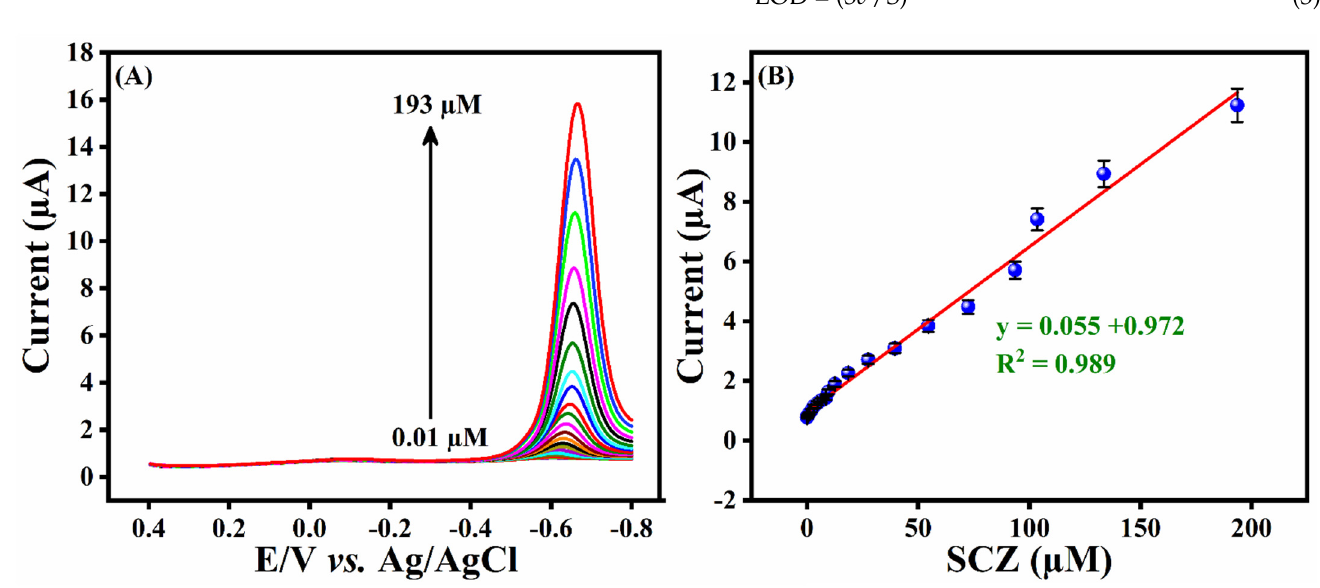
Figure 7. ( A ) DPVs of various concentrations of SCZ (0.01 to 193 μ M) at ZTO/TO MPs/GCE (electrolyte: 0.05 M PBS, pH 7.0), and ( B ) linear plot with peak current plotted as a function of the concentration of SCZ.